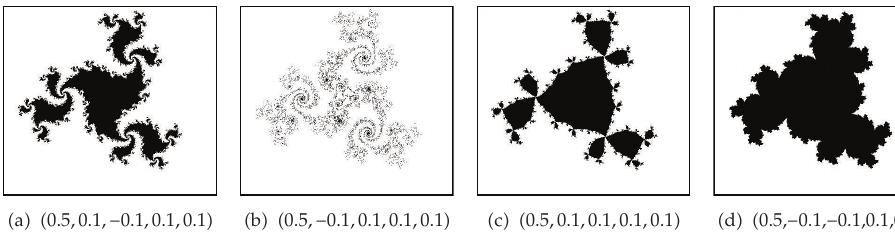
(cid:3) a (cid:4) (cid:3) 0 . 5 , 0 . 1 , − 0 . 1 , 0 . 1 , 0 . 1 (cid:4) Figure 20: The generalized J sets perturbed by the composing noise when α (cid:6) 3 and c (cid:6) 0 . 5 (cid:5) 0 . 5 i .